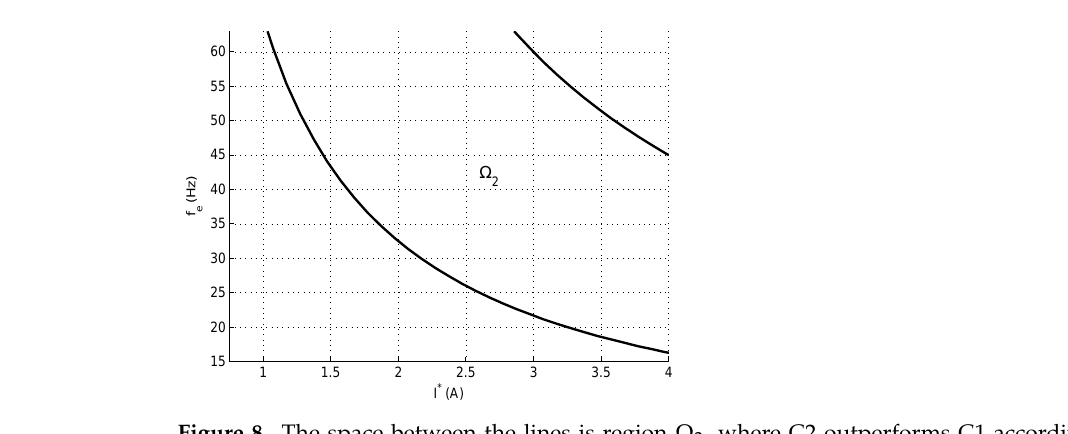
Figure 8. The space between the lines is region Ω 2 , where C2 outperforms C1 according to the selected criteria.